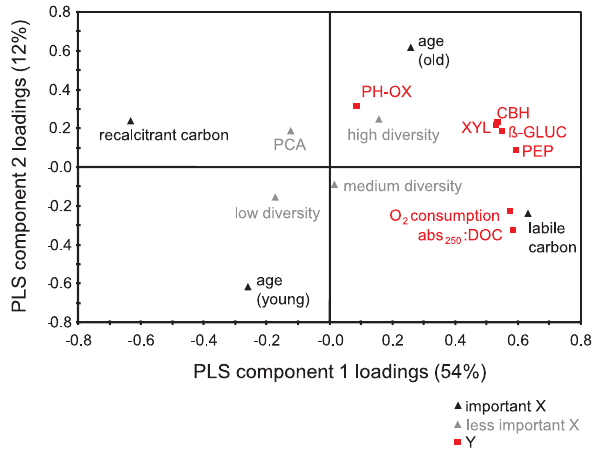
Figure 3. PLS loading plot of community functioning. The plot depicts the correlation structure between X and Y and can be interpreted by drawing a line from any Y-variable through the origin and by identifying the position of orthogonal projections of the X- variables. Factors (X) close to and on the same side of the origin (0,0) are positively related to the response (Y), and factors more distant from the origin are more important. Y-variables close to each other are correlated. Factors are separated according to their importance (VIP). Abbreviations: CBH: cellobiohydrolase, ß-GLUC: beta-glucosidase, XYL: xylosidase, PEP: leucine-aminopeptidase, PH-OX: phenoloxidase, abs250:DOC: change in the ratio of absorbance at 250 nm to dissolved organic carbon concentration over 10 days, PCA: scores on the first axis of Principal Component Analysis of the T-RFLP results.